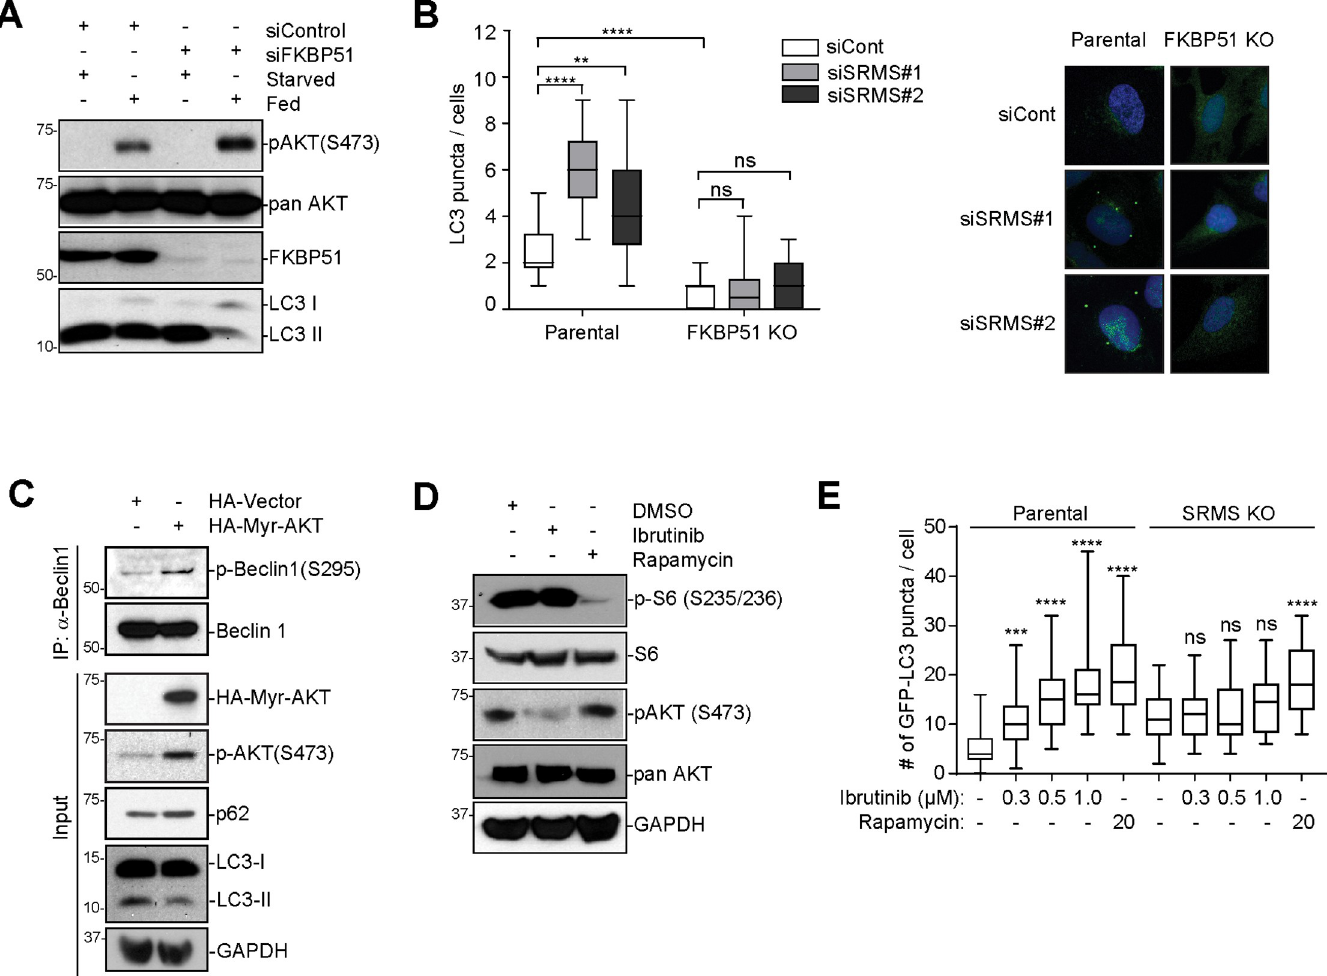
Fig 5. SRMS inhibits autophagy in an FKBP51-dependent manner. ( A ) Depletion of FKBP51 increases p-AKT(S473) and inhibits autophagy in fed conditions. Control siRNA or siRNA targeting FKBP51 was transfected in MDA-MB-231 cells. Seventy-two hours later, cells were fed or starved as indicated for 4 hours. Cell lysates were collected and immunoblotted with indicated antibodies. ( B ) FKBP51 is required for SRMS-mediated regulation of autophagy. SRMS siRNAs were transiently transfected in parental vs. FKBP51 KO U2OS cells. Cells were fixed and stained with anti-LC3 antibody to detect endogenous LC3 puncta. Representative images are shown. The number of puncta per cell from n = 18 cells per condition is shown. ns p > 0.05, �� p < 0.01, ���� p < 0.0001, t test. ( C ) Constitutively active AKT rescues phosphorylation of Beclin1(Ser295) and inhibits autophagy in SRMS KO cells. Myr-AKT was stably expressed in SRMS KO MDA-MB 231 cells. Beclin 1 IP was performed, and lysates were analyzed by western blot using the indicated antibodies. Results shown are representative of 3 independent experiments. ( D ) Ibrutinib does not inhibit mTORC1. MDA-MB-231 cells were treated with 0.5 μ M ibrutinib or 10 nM rapamycin for 4 hours. Lysates were analyzed by western blot with the indicated antibodies. ( E ) Ibrutinib activates autophagosome formation in an SRMS-dependent manner, while rapamycin activates autophagosome formation in an SRMS- independent manner. Parental or SRMS KO U2OS GFP-LC3 cells were treated with vehicle or the indicated concentrations of ibrutinib or rapamycin for 16 hours. Cells were fixed and imaged by confocal microscopy. From left to right, n = 24, n = 33, n = 29, n = 31, n = 26, n = 23, n = 31, n = 31, n = 28, and n = 31 cells were analyzed. ns p > 0.05, ��� p < 0.001, ���� p < 0.0001, t test. The data underlying the figure can be found in S1 Data. FKBP51, FK506-binding protein 51; GAPDH, glyceraldehyde- 3-phosphate dehydrogenase; IP, immunoprecipitation; KO, knockout; siRNA, small interfering RNA; SRMS, Src-related kinase lacking C-terminal regulatory tyrosine and N-terminal myristylation